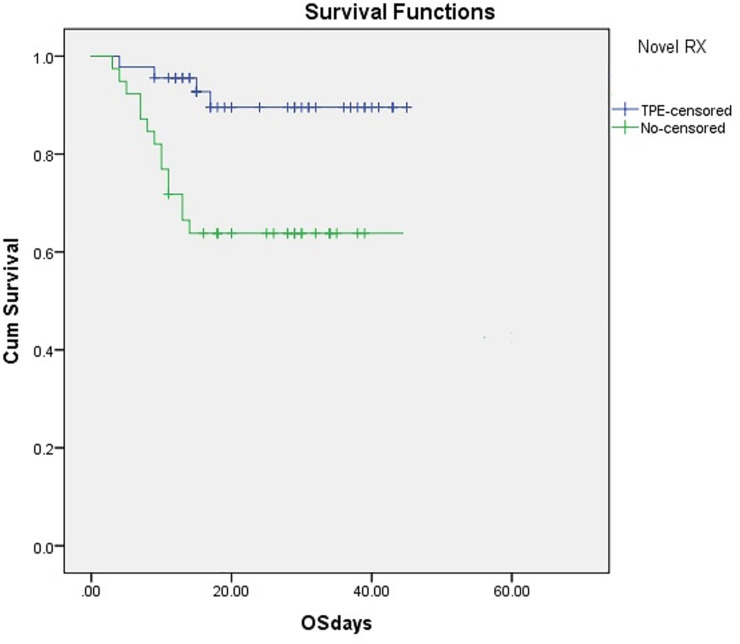
Overall survival in TPE group (91.1%), 95% CI 78.33–97.76; as compared with the PSM controls (61.5%), 95% CI 51.29–78.76 (log rank 0.002), p<0.001.TPE, therapeutic plasma exchange, CI, confidence interval, PSM, propensity score matched, OS, overall survival.